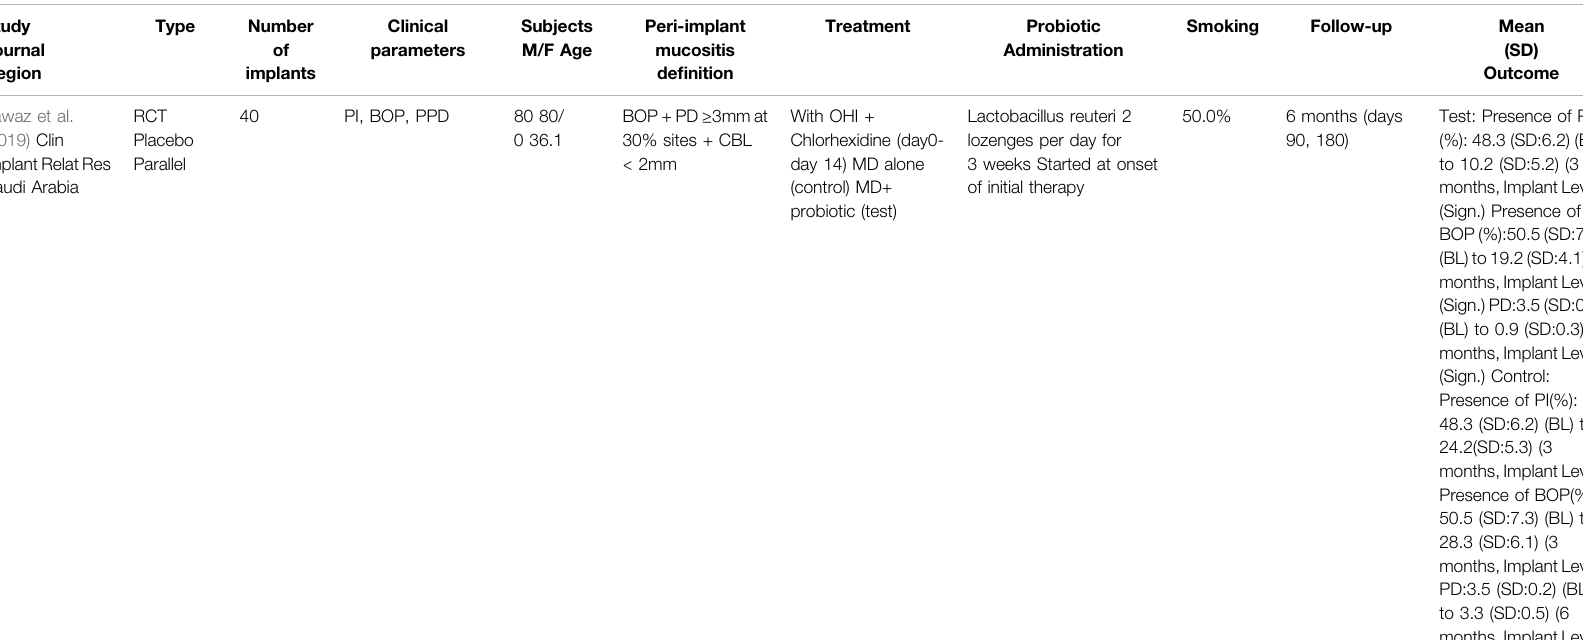
TABLE 2 | ( Continued ) Characteristics of the included